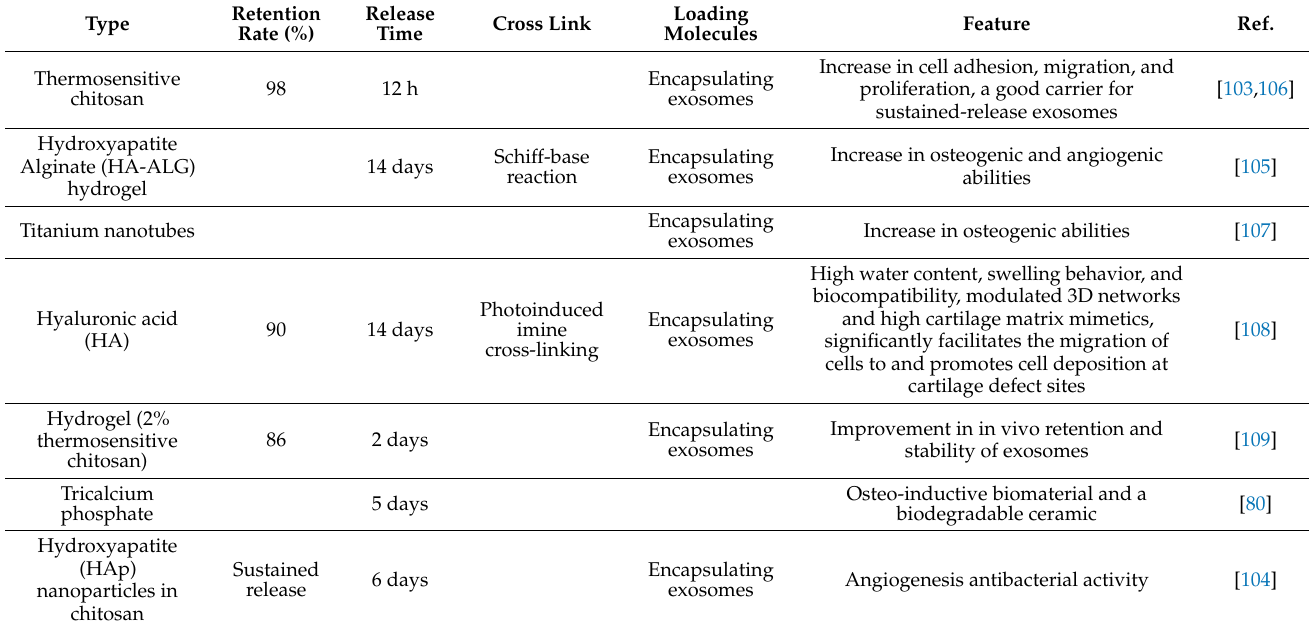
Table 4. A representative list of different biomaterial characteristics used for exosome formulation and